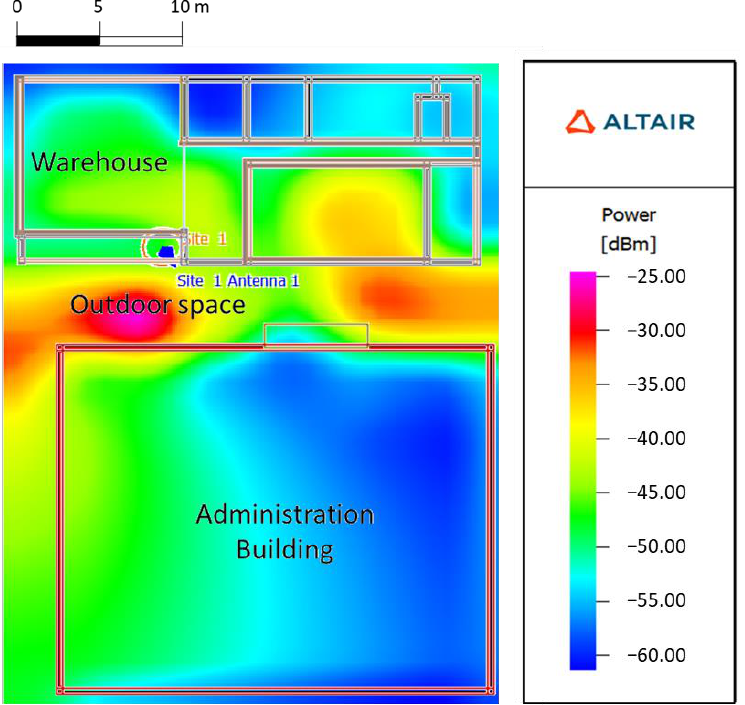
Table 5. Test environment material parameters.